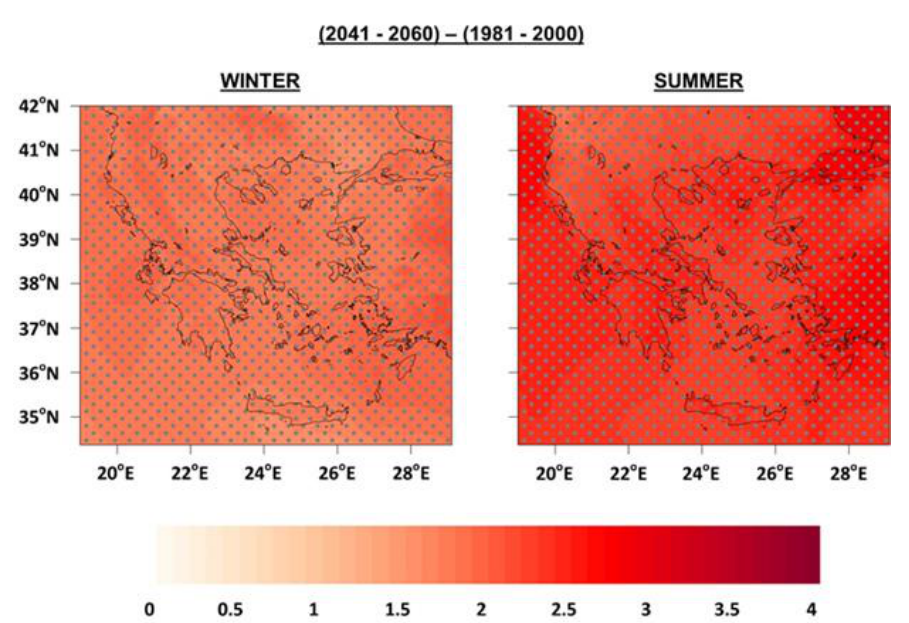
Figure 1. Seasonal maps of differences (winter and spring) for mean temperature (°C) between future period 2041–2060 and reference period 1981–2000. The statistically significant differences are illustrated as dots [11].